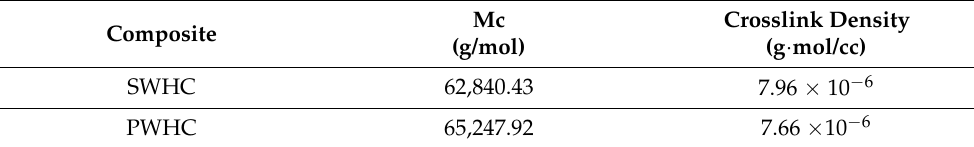
Table 5. Crosslink density and Mc of the SWHC and PWHC.